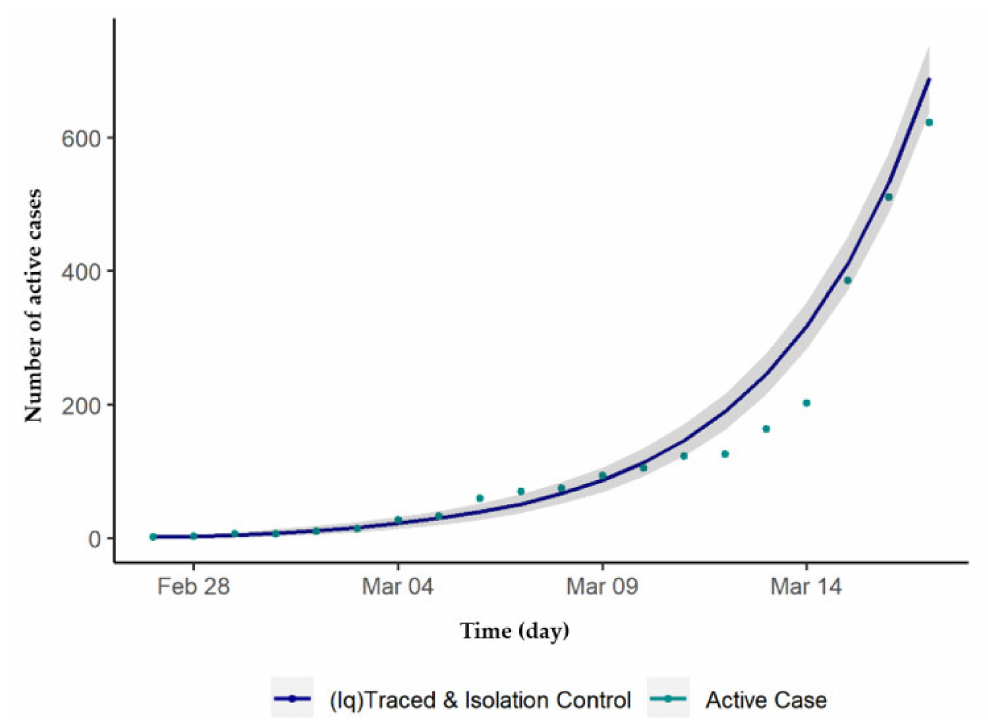
Figure 2. Number of daily active cases and model fit by day, 27 February to 17 March 2020, Malaysia (the grey shades show 95% confidence interval of the fitting).